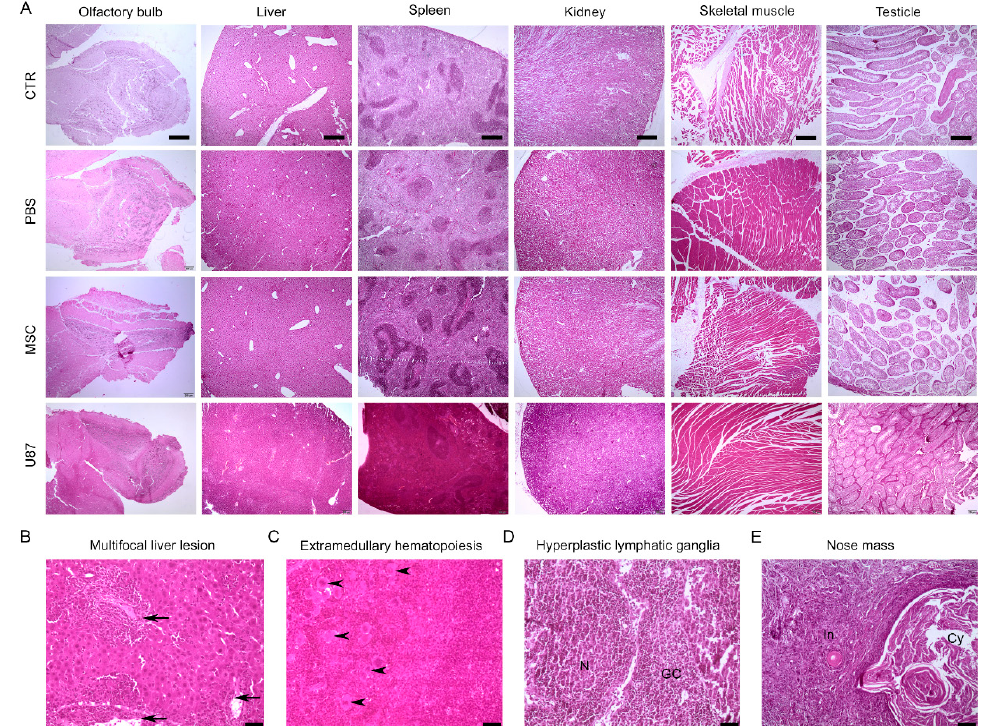
Figure 5. Long-term histological analysis of the major organs does not evidence lesions after intranasal administration of MSCs. Representative images of hematoxylin and eosin staining of major mouse organs for the different experimental groups. ( A ) Comparative histological images of the olfactory bulb, liver, spleen, kidney, skeletal muscle, and testicle. Note that CTR, PBS and MSC animals did not show histological lesions, while U87 mice did. ( B ) Liver tissue from U87 mouse showing cellular infiltration in the periportal area (arrow). ( C ). Spleen tissue from U87 mouse with megakaryocytes (arrowhead) indicating a extramedullary hematopoiesis. ( D ) Atypical axillary mass from U87 mouse with a germinal center (GC) and a nodule (N) that identifies with as hyperplastic lymphatic ganglia. ( E ) Atypical nose cyst (Cy) from U87 mouse with inflammation (In) of the adjacent tissue. Scale bar: ( A ) 400 μ m; ( B – D ) 50 μ m, ( E ) 100 μ m. n = 3–4 per group.